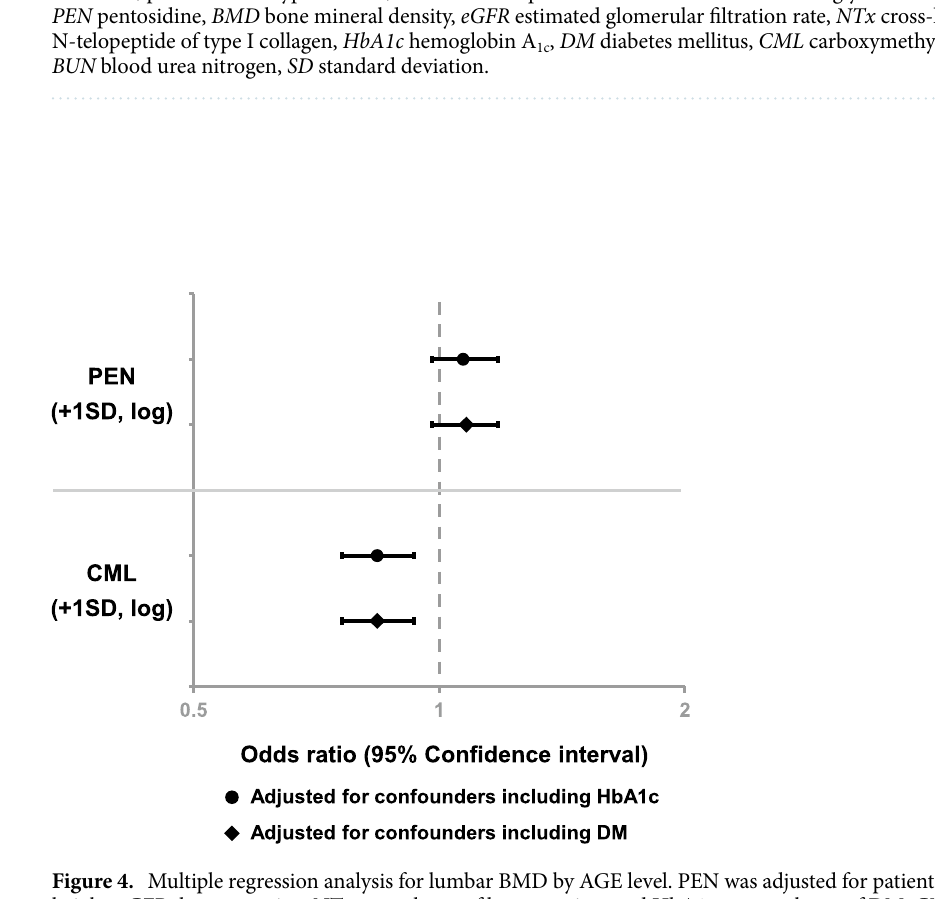
Figure 4. Multiple regression analysis for lumbar BMD by AGE level. PEN was adjusted for patient age, body height, eGFR, homocysteine, NTx, prevalence of hypertension, and HbA1c or prevalence of DM. CML was adjusted for patient age, body height, hip fat, albumin, BUN, sclerostin, prevalence of hypertension, and HbA1c or prevalence of DM. BMD bone mineral density, AGE advanced glycation end product, PEN pentosidine, eGFR estimated glomerular filtration rate, NTx cross-linked N-telopeptide of type I collagen, HbA1c hemoglobin A 1c , DM diabetes mellitus, CML carboxymethyl-lysine, BUN blood urea nitrogen, SD standard